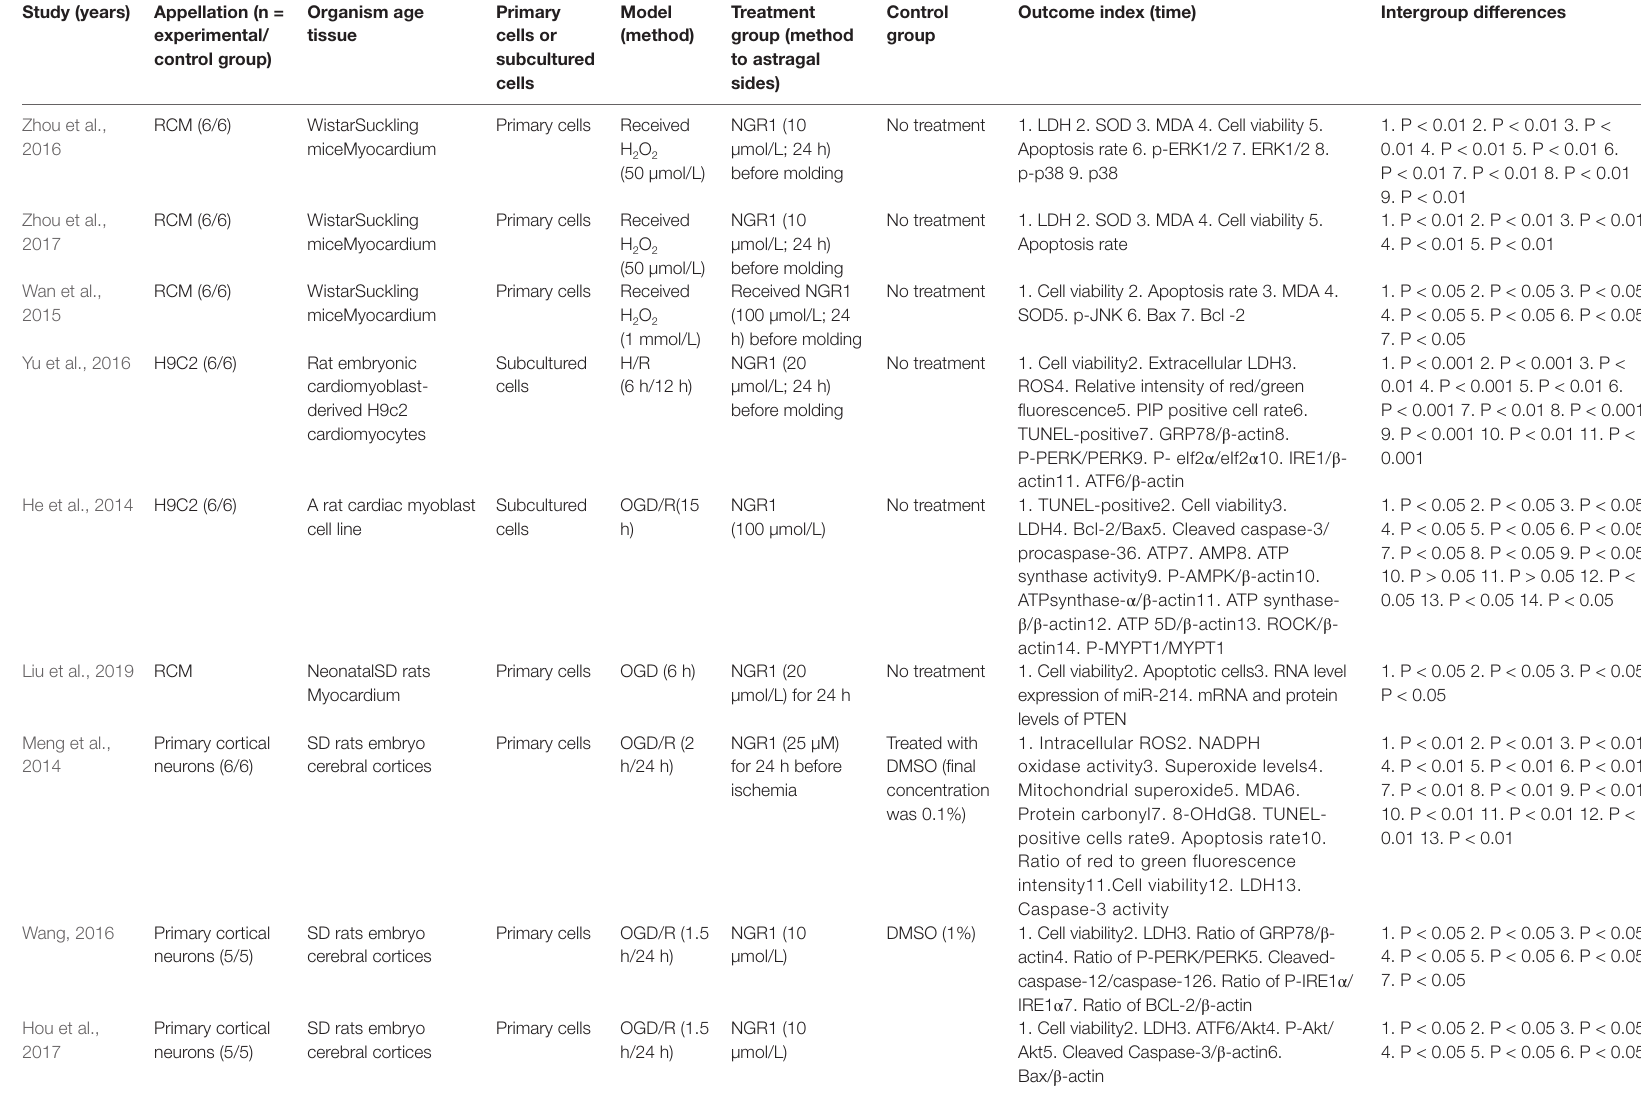
TABLe 2 | Characteristics of the 11 included cell